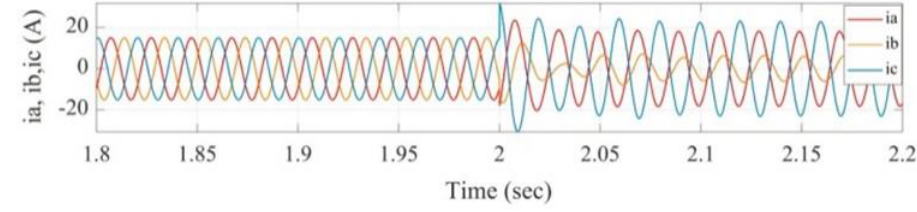
Figure 7. Modeling of an induction motor with faults in its rotor.